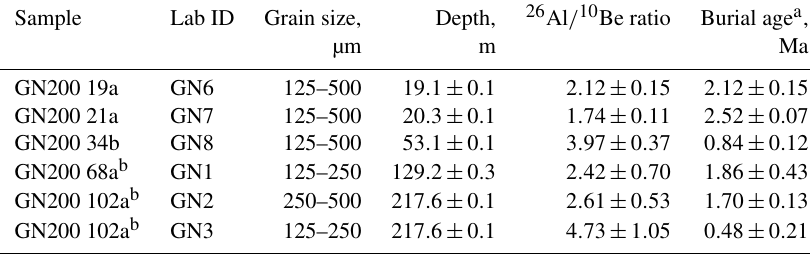
Table 1. Information for burial ages from drill core GN200. Sample Lab ID Grain size, Depth, 26 Al / 10 Be ratio Burial age a , µm m Ma GN200 19a GN6 125–500